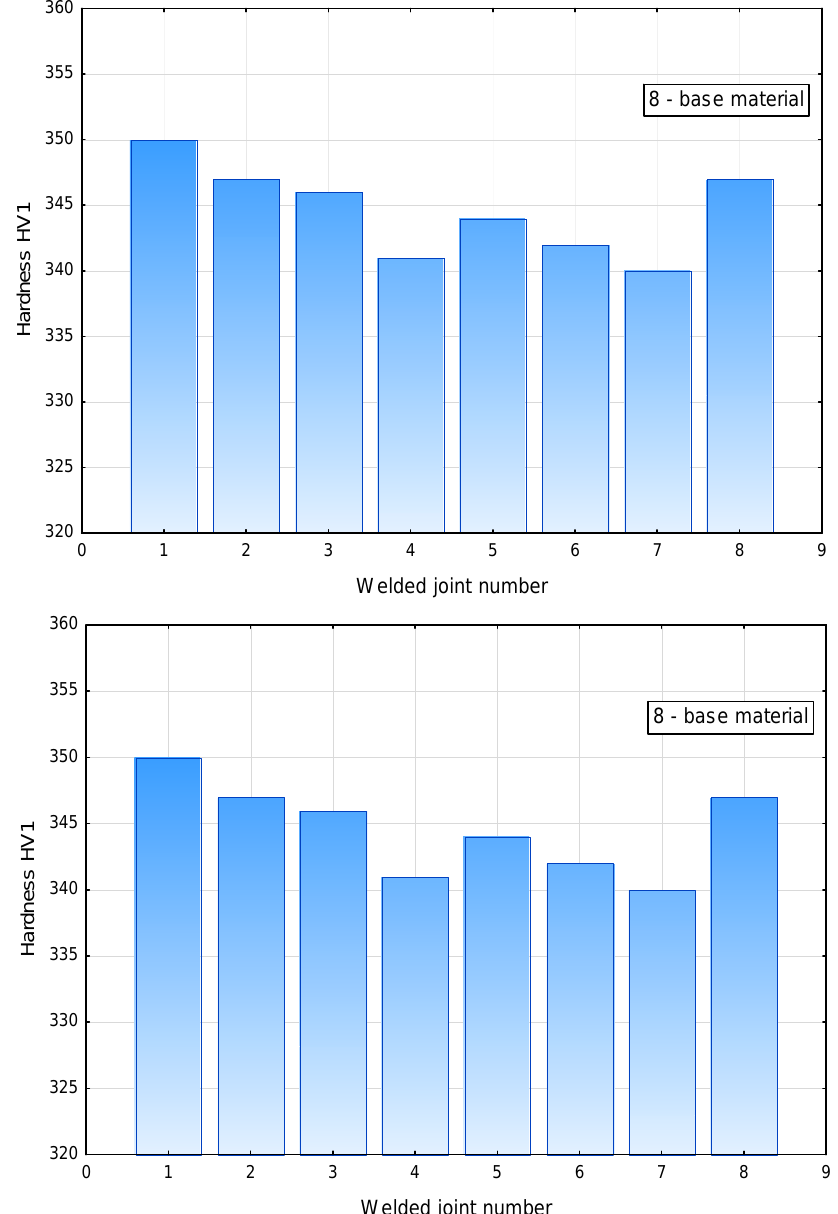
Figure 16. Averaged hardness in the weld area of the T ‐ joints.